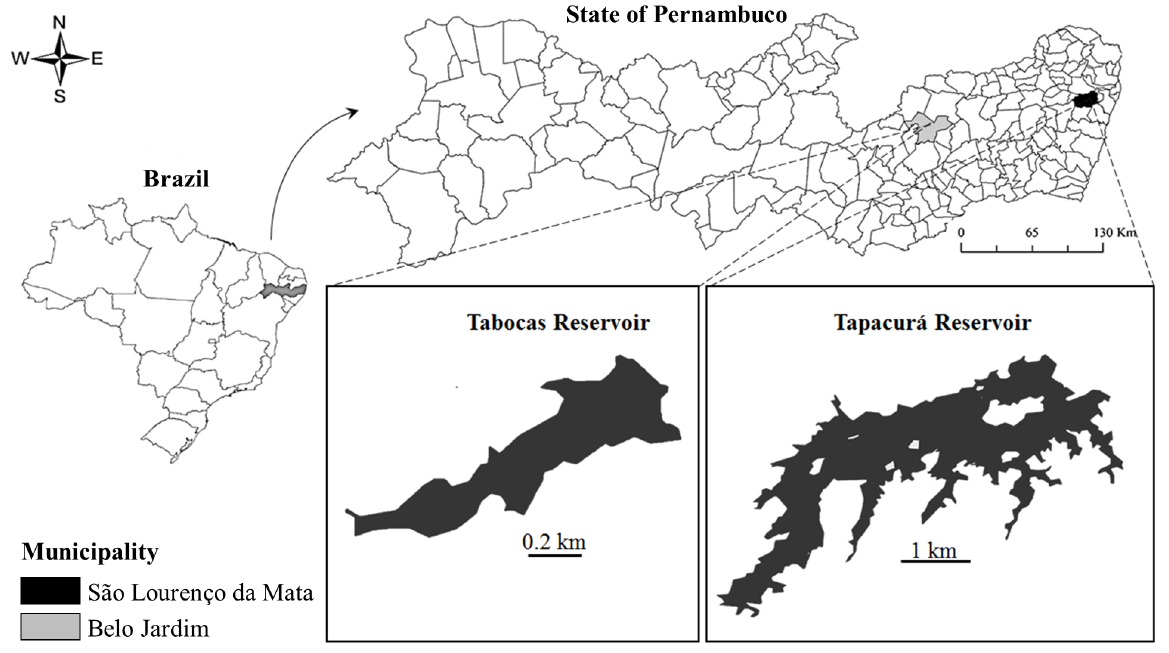
Figure 1. Location of the Tapacurá (supereutrophic) and Tabocas (mesotrophic) reservoirs in the municipalities of São Lourenço da Mata and Belo Jardim in the State of Pernambuco, Northeast,